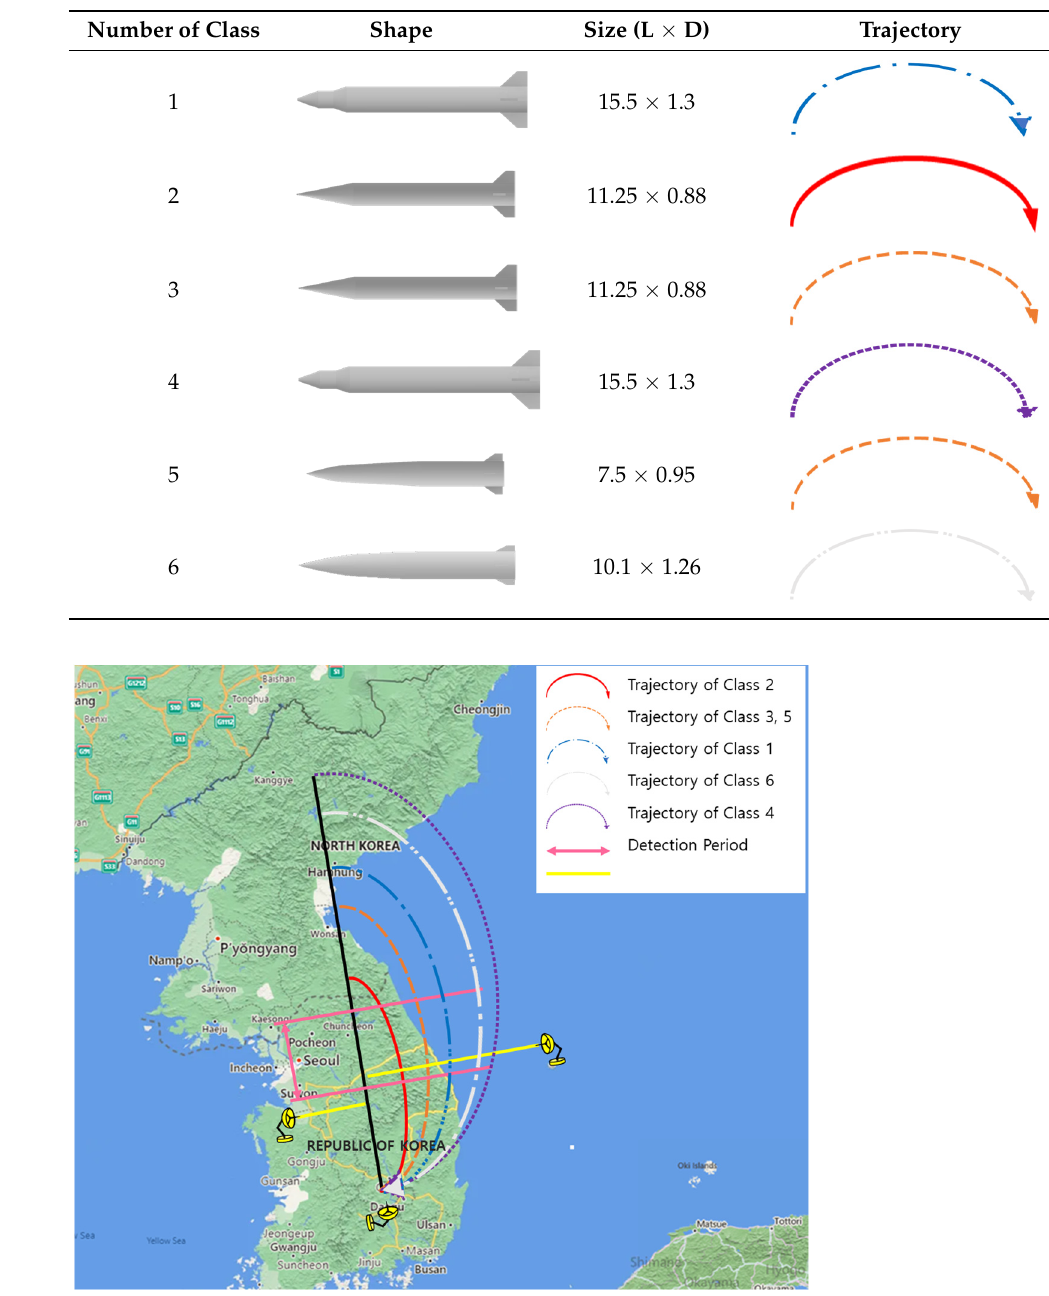
Table 1. Information on the shape, size, and trajectory of missiles.